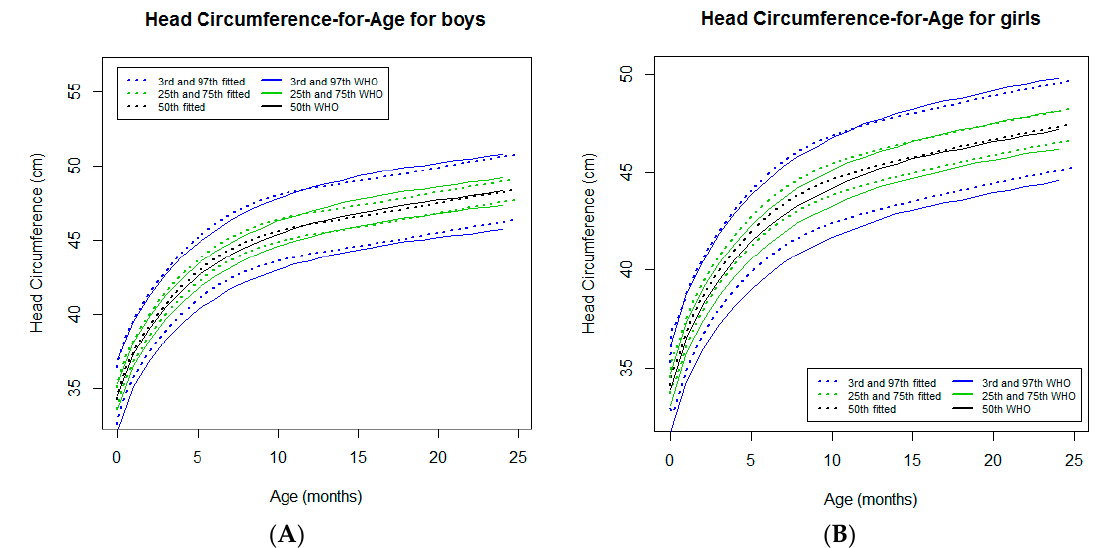
Figure 6. Comparison of the WHO Child Growth Standards (solid lines) with smoothed centile curves (dotted lines) of measured head circumference for age for boys ( A ) and girls ( B ) from the neonatal period to 24 months of age.